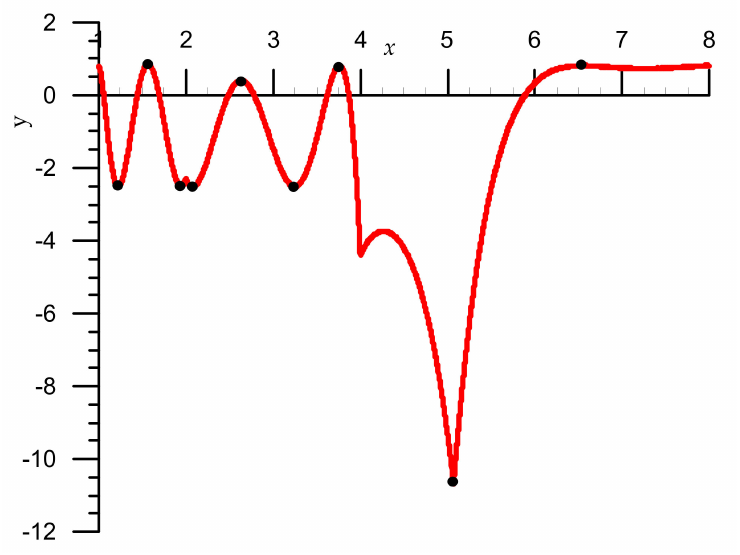
Figure 4. The first iteration relative error graphs Algorithm 5 for the interval x ∈